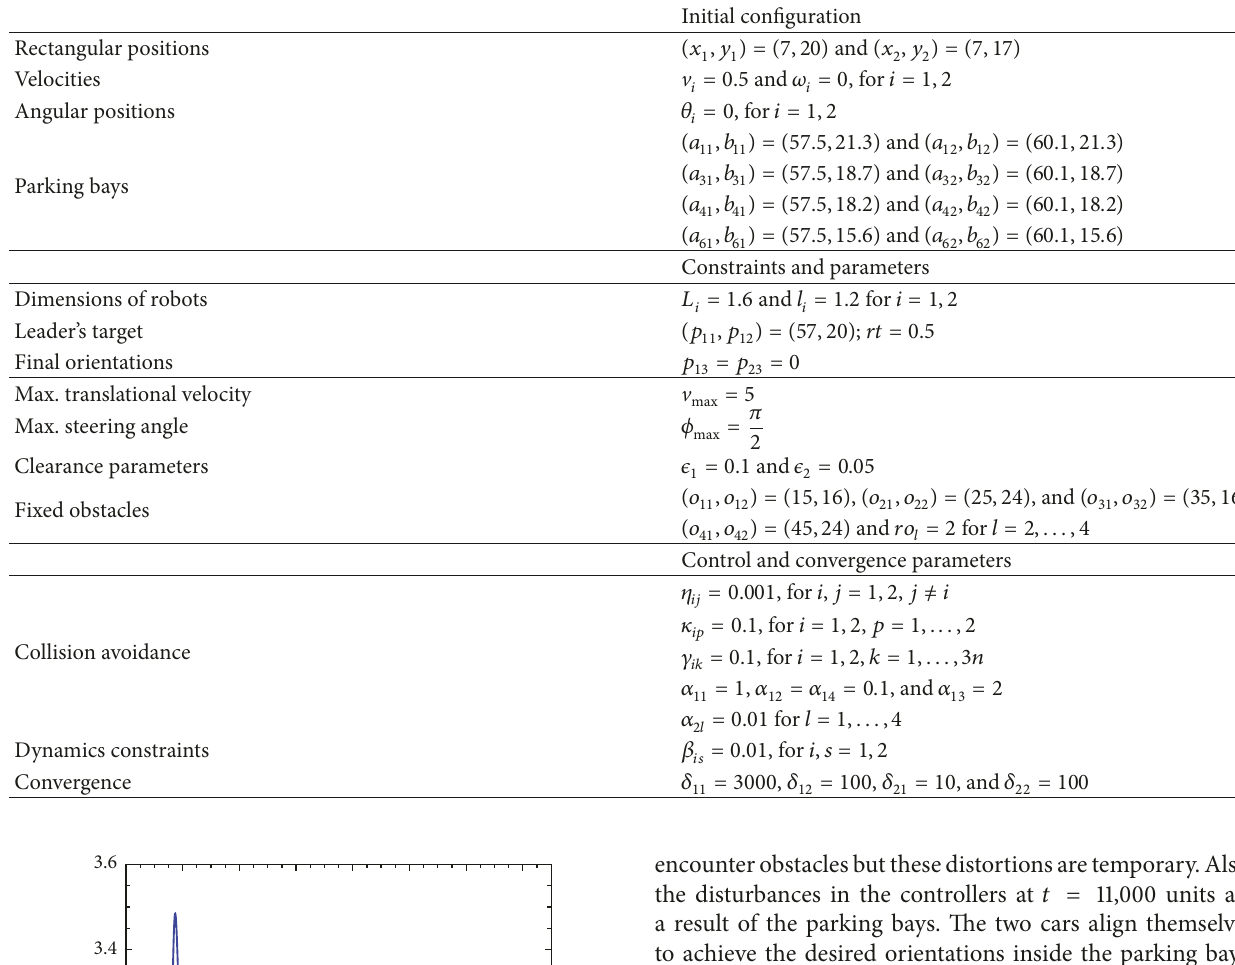
Table 1: Numerical values of initial and final states, constraints, and parameters for Scenario 1.